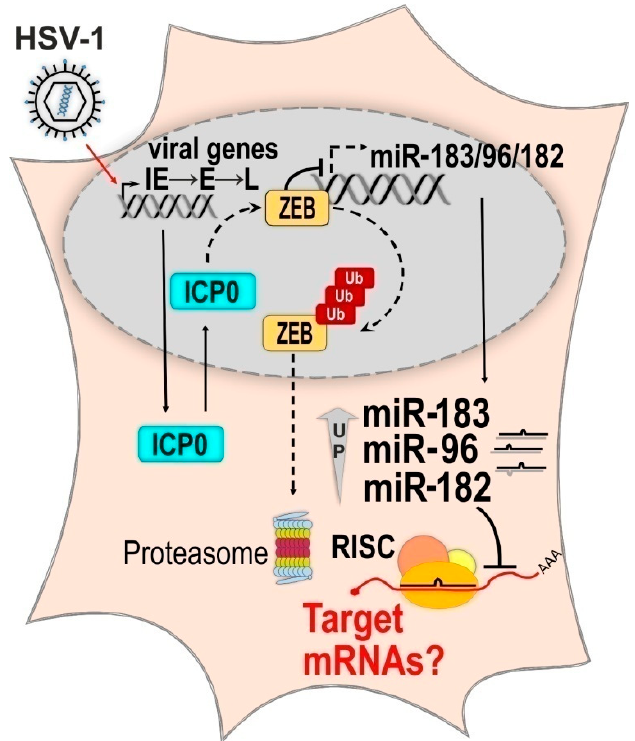
Figure 3. The molecular mechanism of the miR-183/96/182 cluster upregulation in HSV-1 infection. HSV-1 expresses its genes in a controlled cascade of gene expression, first immediate early (IE), early (E), and then late (L) genes. IE protein ICP0 directs host protein Zinc Finger E-Box Binding Homeobox (ZEB) for ubiquitin-dependent proteasomal degradation and de-represses the miR-183/96/182 cluster [86]. The targets of the co-expressed miR-183, miR-96, and miR-182 are unknown. Adapted from Lutz et al. [86] .